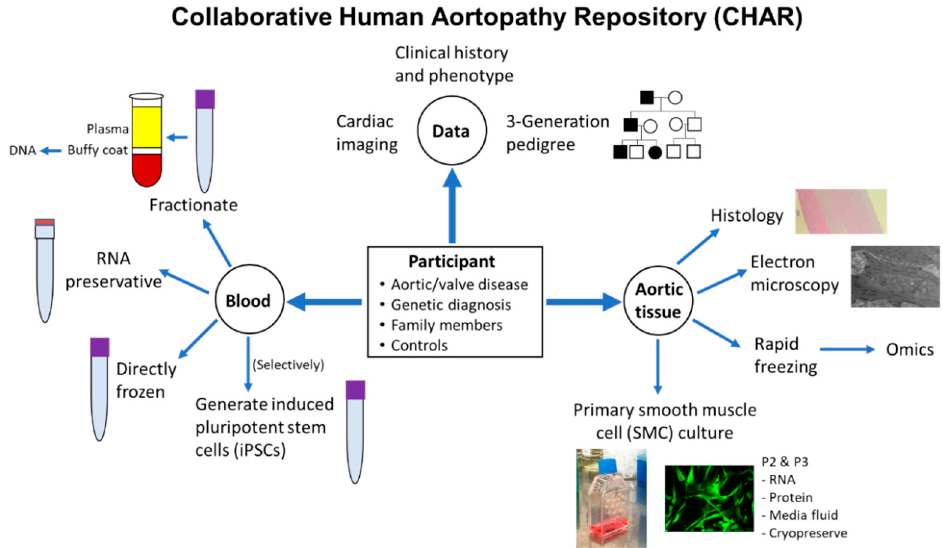
Figure 1. Synopsis of CHAR study’s eligibility, data collection, and processing of blood and aortic tissue biospecimens. P2: Passage 2; P3: Passage 3.